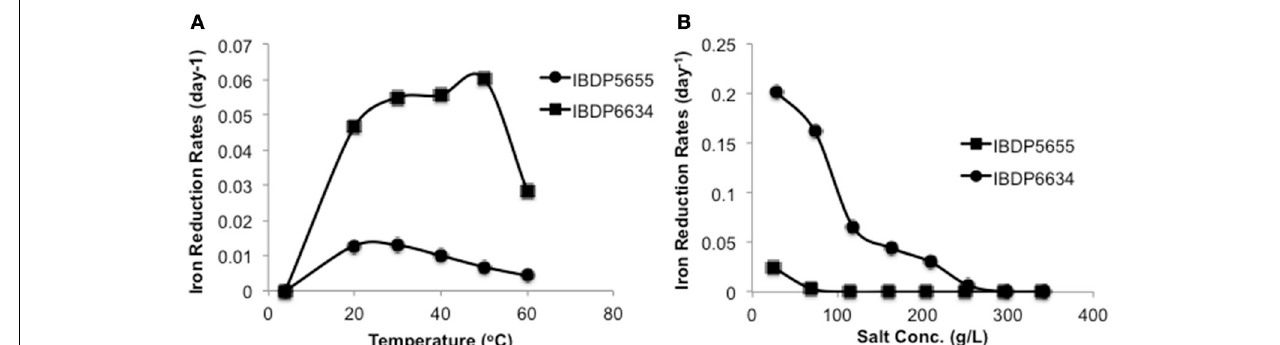
FIGURE 4 | Reduction of ferrihydrite by IBDP5655 and IBDP6634 at different temperatures (A) and salinities (B). The cultures for temperature tolerance (A) were prepared in the medium containing 40% (v:v) filter sterilized formation water. The cultures for salinity tolerance were grown at 42 ◦ C (B) . For both experiments, the un-inoculated controls were prepared for